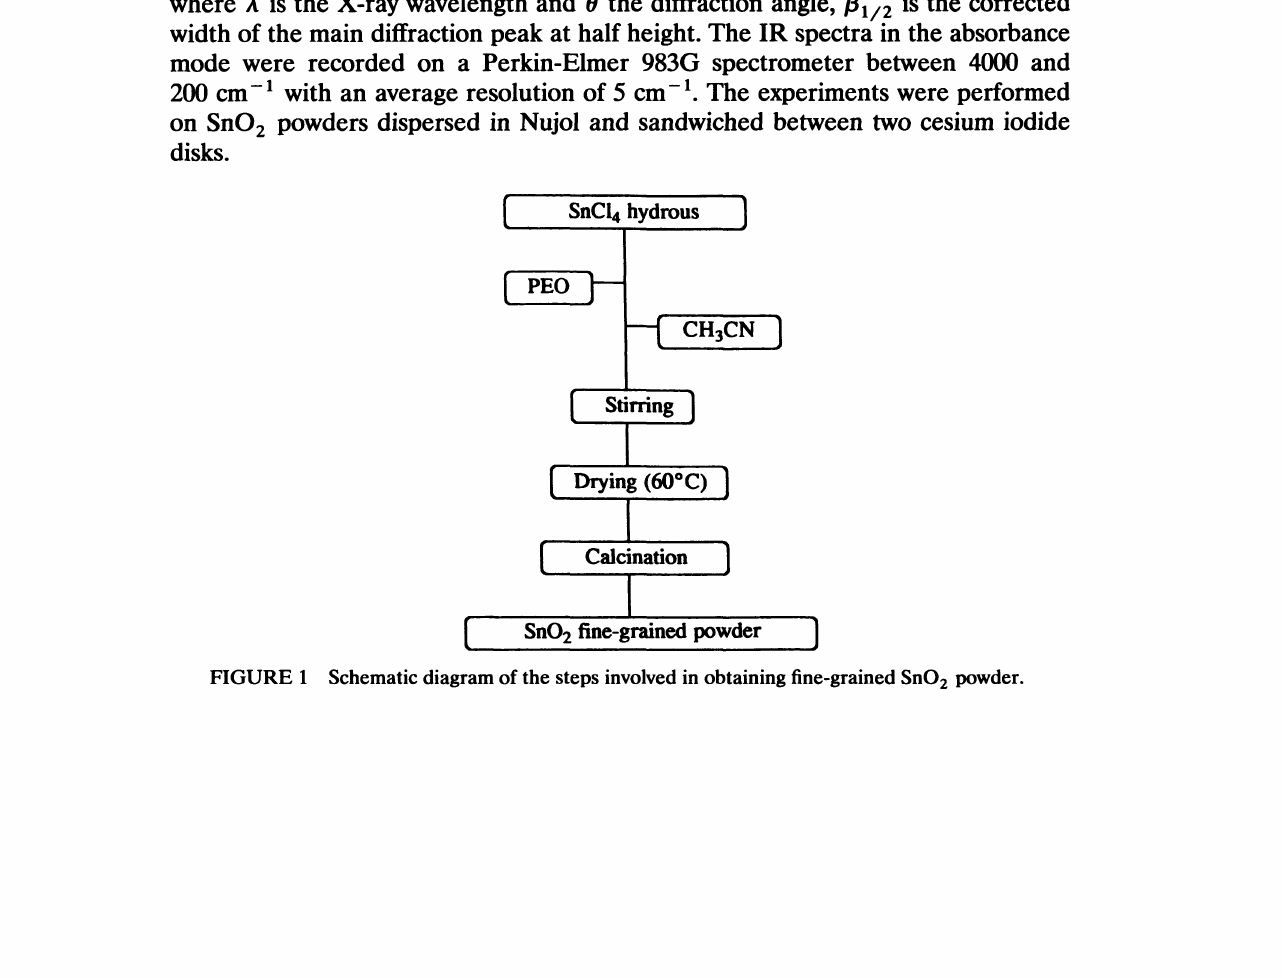
Schematic diagram of the steps involved in obtaining fine-grained SnO 2